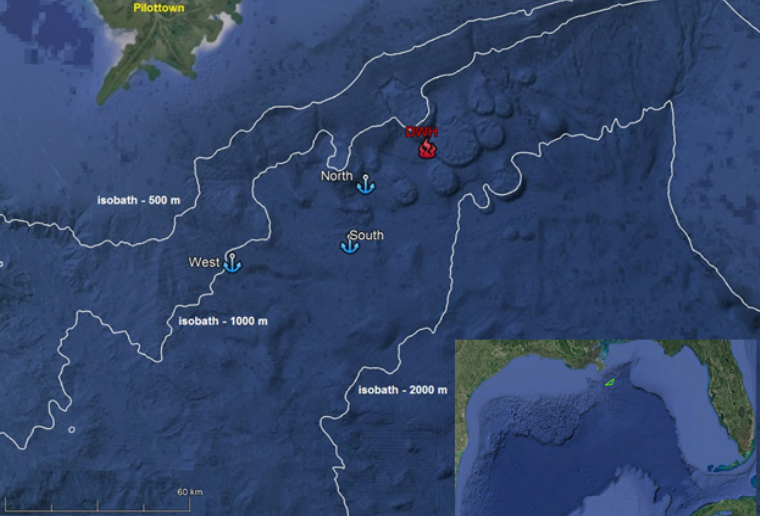
Figure 1. EARS deployment sites (Northern, Southern and Western). The 500, 1000, and 2000 m isobaths are shown. The fire symbol represents the 2010 Deepwater Horizon (DWH) incident site (28°44.65 ′ N, 88°21.10 ′ W). The distance between the Northern and Southern sites is 27 km, the distance between the Northern and Western sites is 55 km, and the distance between the Southern and Western sites is 35 km. Yellow triangle indicates the study area. Table 1. Geographic locations of EARS buoy moorings and the start/deployment and end/retrieval dates.